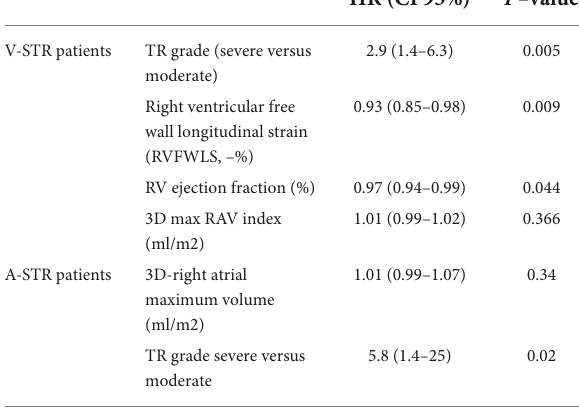
TABLE 4 Multivariable Cox regression to identify the variables associated with the combined endpoint in patients with atrial and ventricular secondary tricuspid